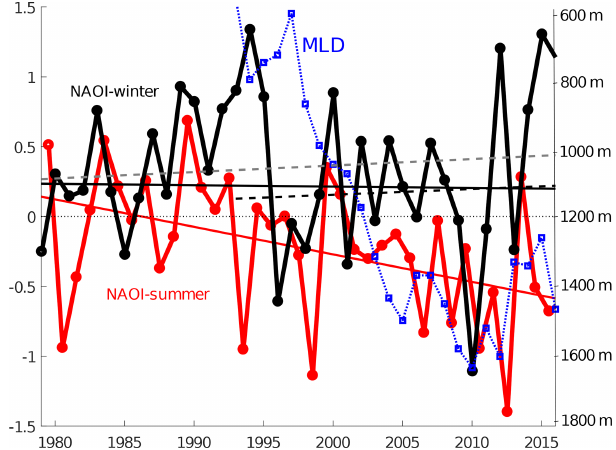
Figure 7. Cold-season NAO index (black, November–April) and warm season NAO index (red, May–October) with linear trends. Additionally plotted are the trends of cold-season NAO index since 1993 (dashed black line, October–April) and for the winter season (dashed gray line, January–April). The blue line shows the maxi- mum MLD in the Greenland Sea derived from the ARMOR dataset (see Bashmachnikov et al., 2019, for